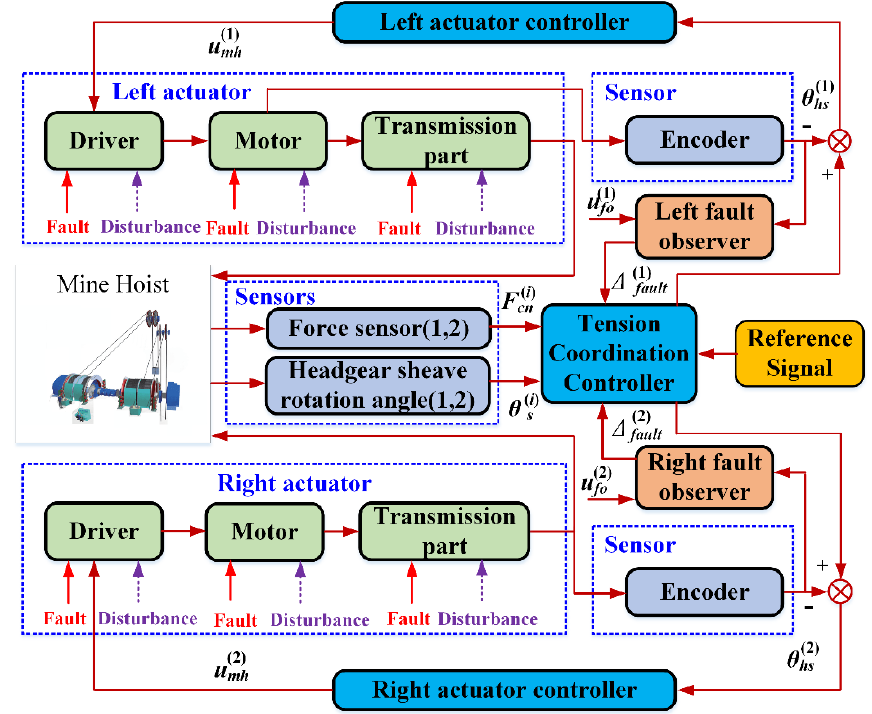
Figure 4. Overall Architecture of Electromechanical Actuators Fault-Tolerant Control System.